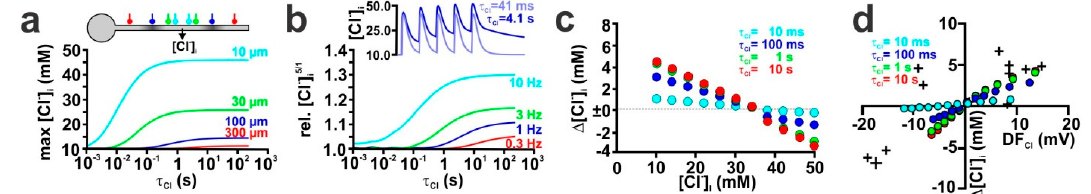
Figure 9. Influence of Cl ⁻ diffusion and the kinetics of transmembrane Cl ⁻ transport on GABA-induced [Cl ⁻ ] i transients. ( a ) Dependency between τ Cl and [Cl ⁻ ] i determined in the middle between 2 simultaneously stimulated synapses (parameters as in a) located 10 µM, 30 µM, 100 µM and 100 µm from the node of [Cl ⁻ ] i recording. The inset represents a schematic illustration of the spatial arrangement. ( b ) Analysis of temporal summation of activity-dependent [Cl ⁻ ] i transients upon 5 consecutive GABA stimuli (parameters as in a ) provided at frequencies of 0.3 Hz, 1 Hz, 3 Hz and 10 Hz in the dendrite + soma arrangement. The inset illustrates typical [Cl ⁻ ] i traces obtained at 3 Hz with τ Cl of 41 ms and 4.1 s. The ratio in the [Cl ⁻ ] i between the first and fifth stimulus (rel. [Cl ⁻ ] i5/1 ) shows a sigmoidal dependency on τ Cl . Note that with higher stimulus frequencies faster τ Cl are required to prevent summation of [Cl ⁻ ] i transients. ( c ) Dependency between maximal GDP-induced [Cl ⁻ ] i changes (g GABA = 0.789 nS, τ GABA = 37 ms, P HCO3 = 0.18, τ HCO3 = 1 s, n GABA = 395) and initial [Cl ⁻ ] i for different τ Cl in the reconstructed CA3 neuron ( d ) Dependency between DF Cl and the GDP-induced [Cl ⁻ ] i transients obtained with different τ Cl.